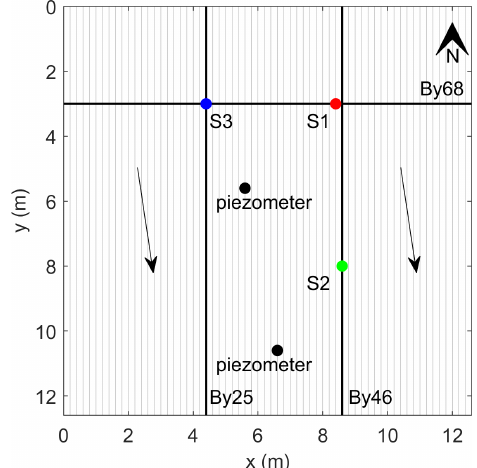
Figure 3. Schematic map of the experimental plot. The solid lines represent the measured profiles; the bold lines represent the position of the profiles discussed in this paper (By 25, By 46, and By 68). The arrows indicate the groundwater flow direction. The points rep- resent the locations of fluid (S1, S2, and S3) and freeze-core (S1, S2) samples as well as the position of piezometric tubes, where the water level was